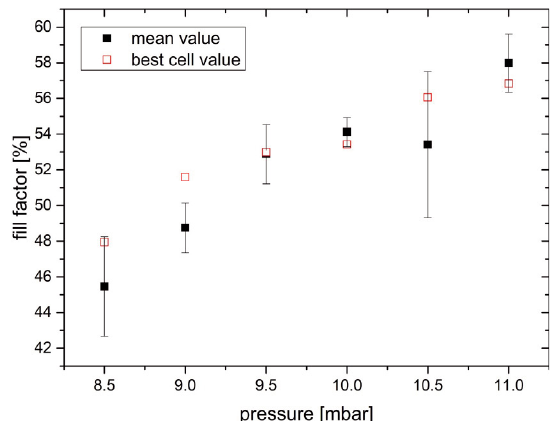
Fig. 5. Dependency of fill factor values on the increase of process pressure.